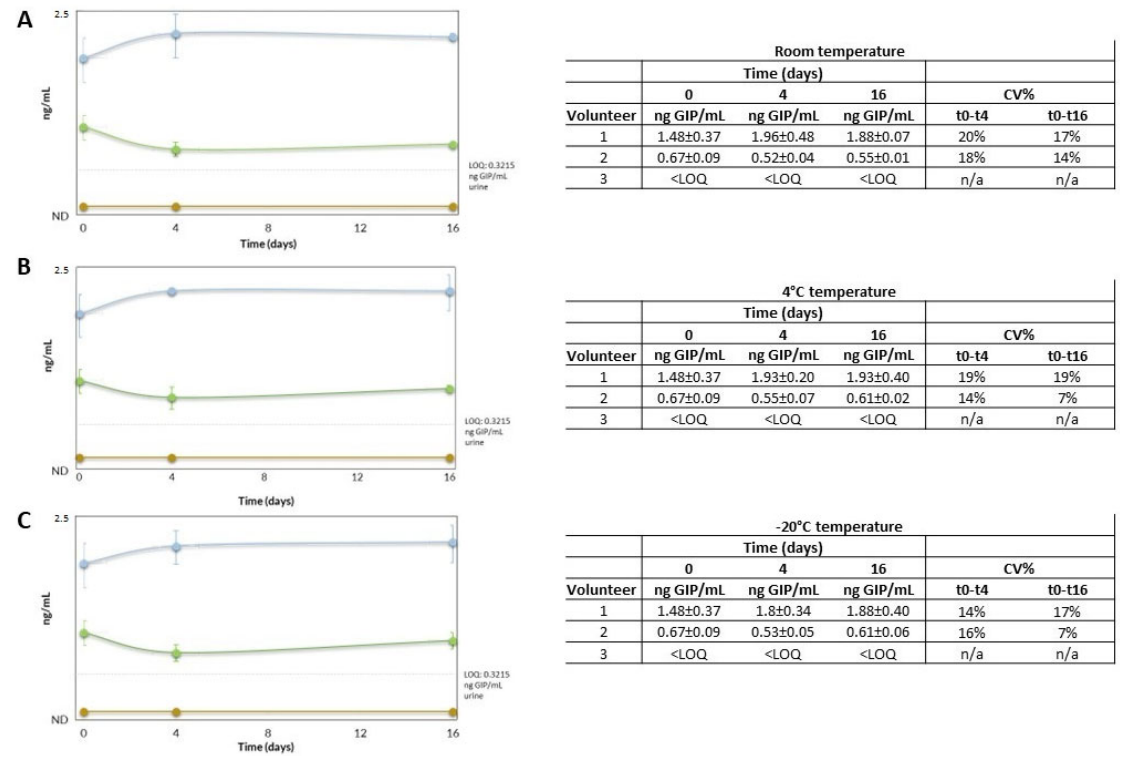
Figure 4. Stability of urinary GIP over a 16-day period. ( A ) room temperature. ( B ) 4 °C. ( C ) − 20 °C. Volunteer one is represented in blue, two in green, and three in yellow. Each point represents the mean of duplicate measurements plus the SD if the GIP was measurable. GIP, gluten immunogenic peptides; LOQ, limit of quanti fi cation; ND, non-determined; n/a, non-applied.